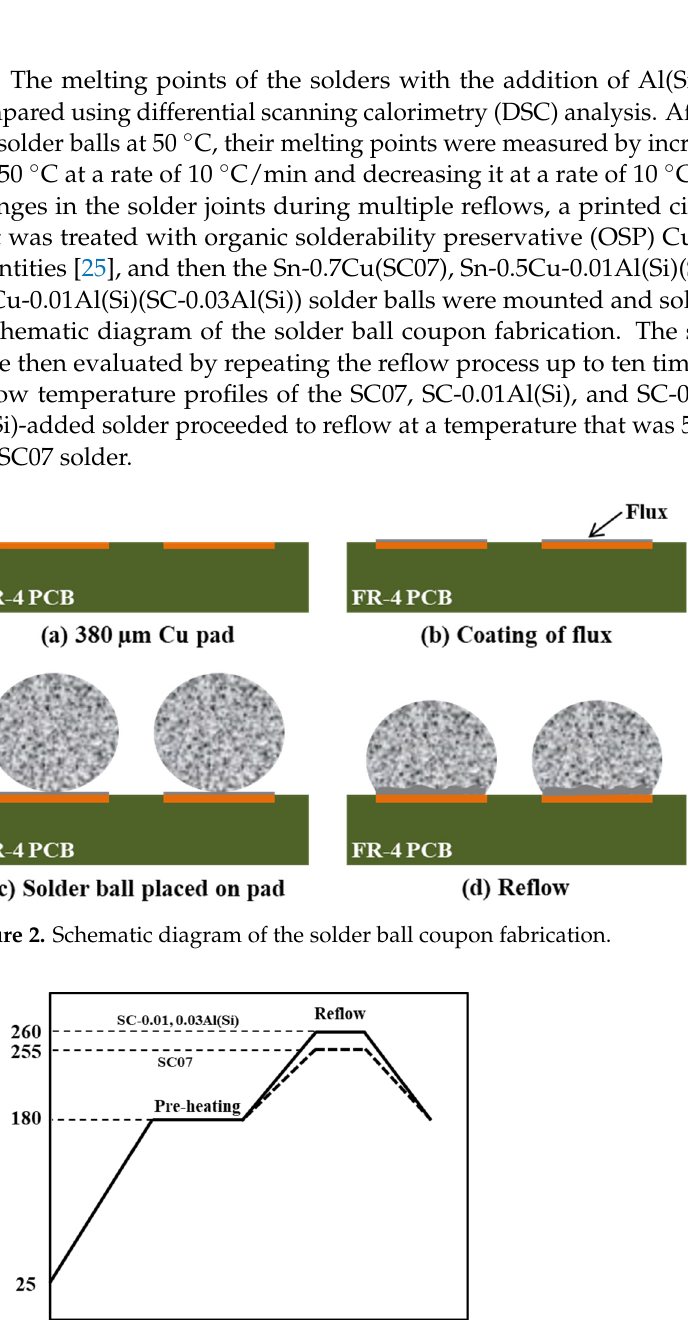
Figure 1. Schematic diagram of the solder ball manufacturing process.